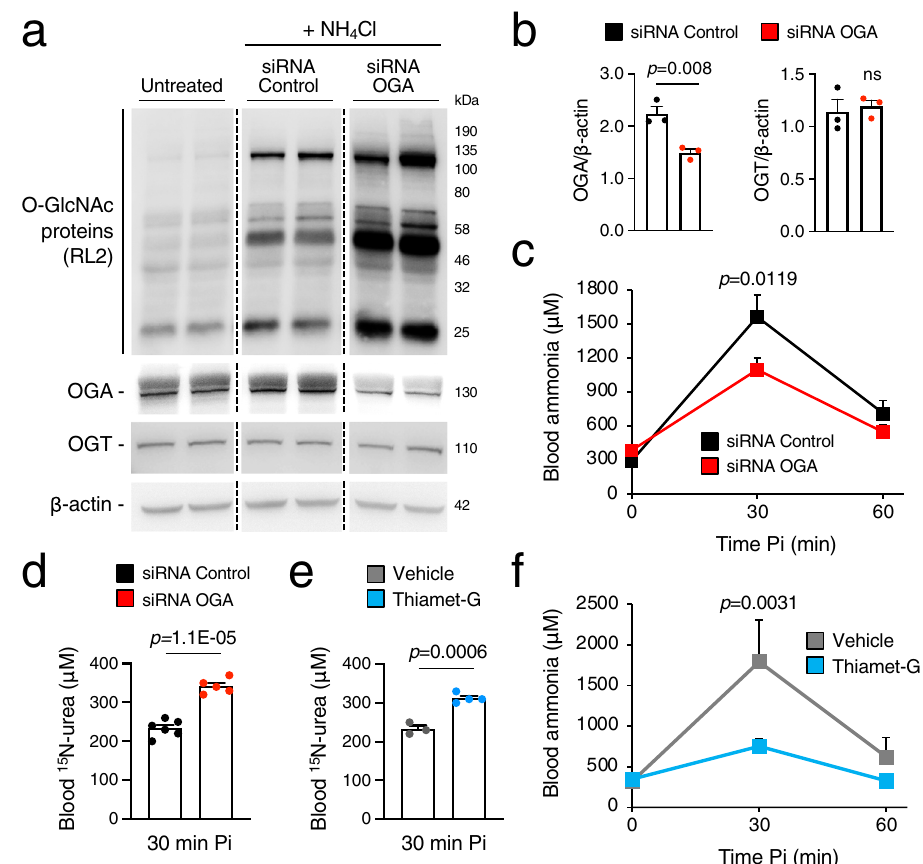
Fig. 3 | Downregulation or pharmacologic inhibition of OGA enhances urea- genesis and ammonia detoxi fi cation. a Western blot analyses of O-GlcNAc pro- teins,OGAandOGTproteinsinliversharvested1.0hafterthei.p.injectionsofNH 4 Cl (10mmol/kg) in C57BL/6 wild-type (WT) mice injected i.v. with siRNA (1mg/kg) againstmurineOGARNAorwithanon-targetingnegativecontrolsiRNA6daysbefore the ammonia challenge. Control samples of untreated mouse livers are also shown. Samples were run on the same gel but were non-contiguous. b Densitometric quan- ti fi cations of the OGA and OGT Western blots ( n =3 mice/group). p =0.0081 (Unpaired t -test). c Blood ammonia at baseline and after i.p. injection of NH 4 Cl (10mmol/kg)in negative controlsiRNA( n =10) and OGA-siRNA-treated ( n =12) mice.